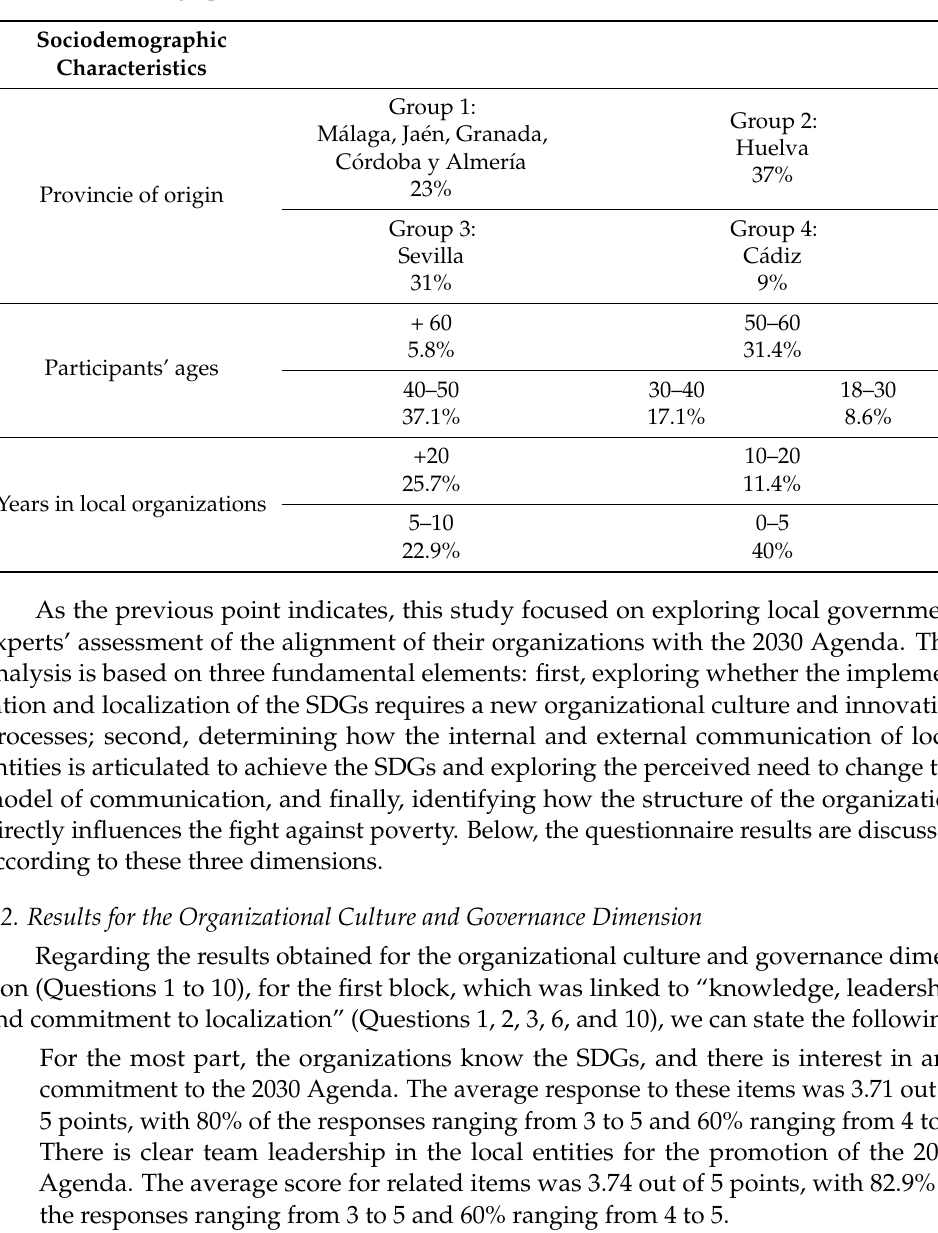
Table 2. Sociodemographic